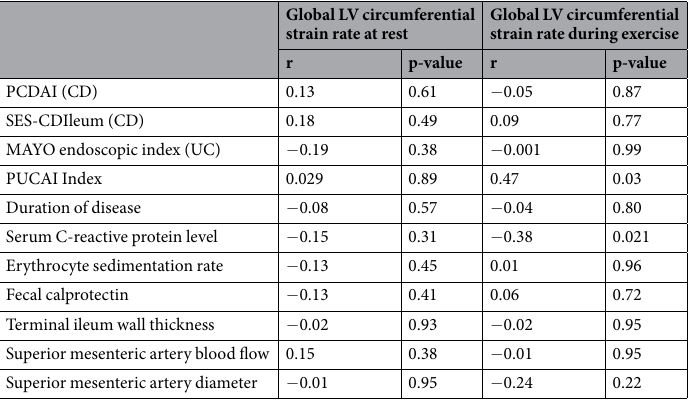
Table 5. Correlation analyses of disease activity scores, basic laboratory and abdominal ultrasound findings with global LV circumferential strain rate at rest and during exercise in pediatric IBD patients using Pearson’s correlation analysis.